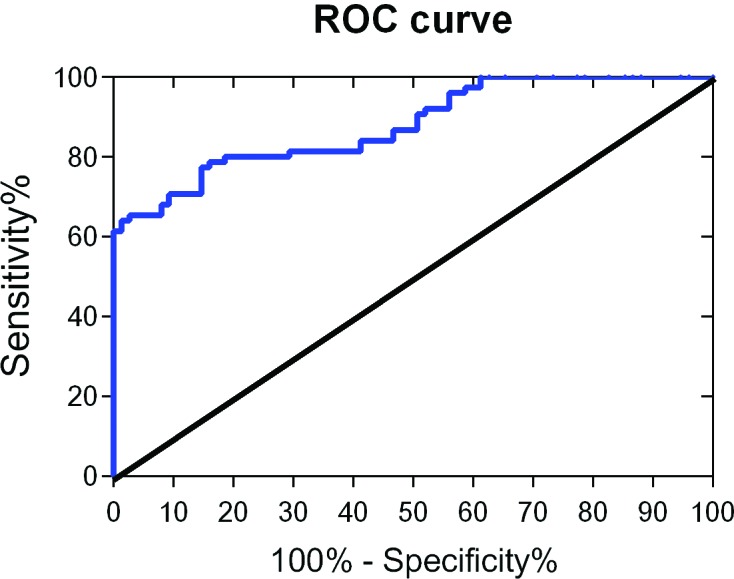
The AUC for diagnostic efficiency of serum miRNA-378 in renal cell
carcinoma (RCC) patients.